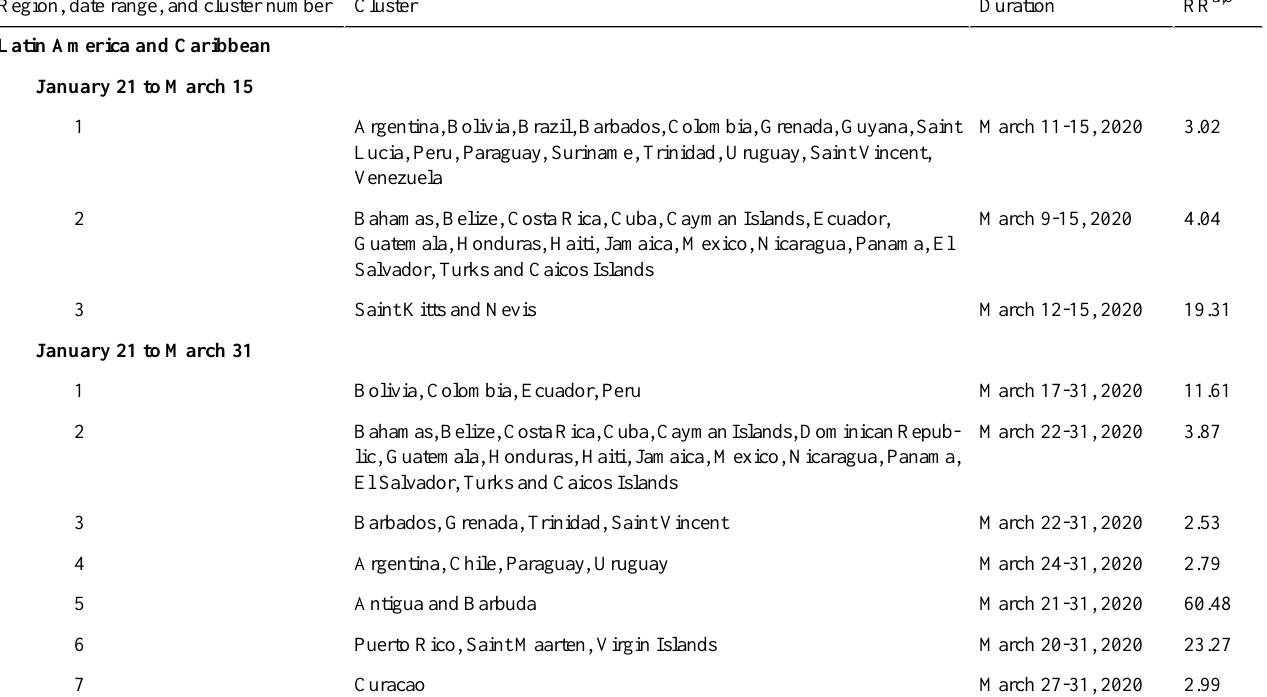
Table 1. Emerging COVID-19 space–time clusters and their RR for having more observed than expected COVID-19 cases, from January 21 to March 15 and March 31, 2020, at the country level within the Latin American, Caribbean, and African regions. Latin America and